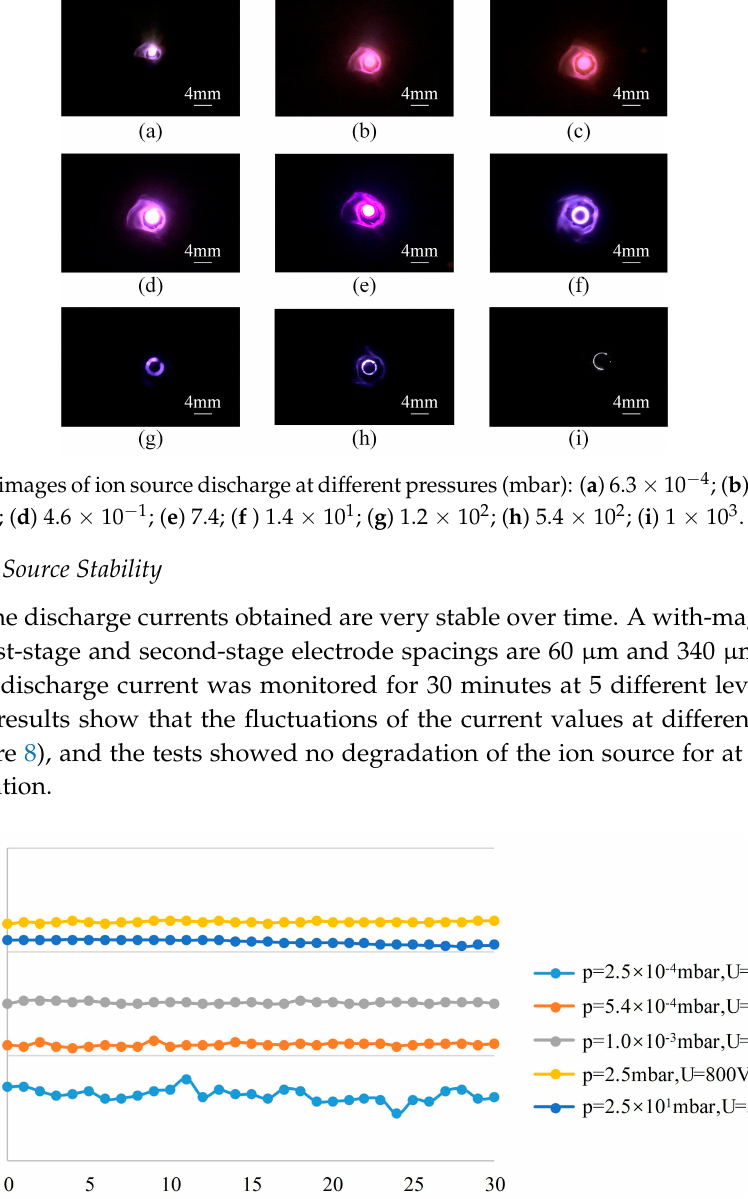
Figure 6. The measurement of the properties of the with-magnet ion source: ( a ) the relation between discharge current and pressure; ( b ) the relation between discharge current and voltage U.